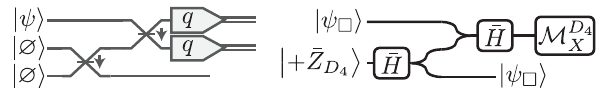
FIG. 13. Teleportation-based error correction for a single- mode square code. The physical circuit on the left can be reinterpreted using the logical circuit on the